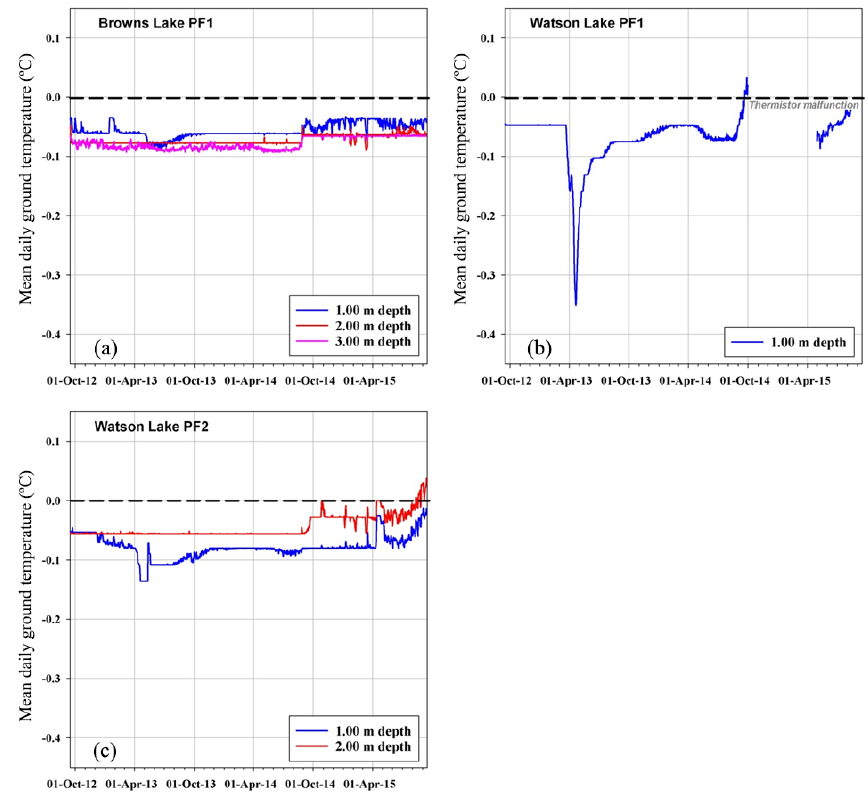
Figure 6. Mean daily ground temperature data plots indicating the presence of permafrost in the western Kenai Peninsula lowlands for the period of 16 September 2012 to 15 September 2015: (a) Browns Lake PF1 site, (b) Watson Lake PF1 site, and (c) Watson Lake PF2 site. Top-down permafrost thaw occurred at Watson Lake PF1 during the fall of 2014 and bottom-up permafrost thaw occurred at Watson Lake PF2 during the fall of